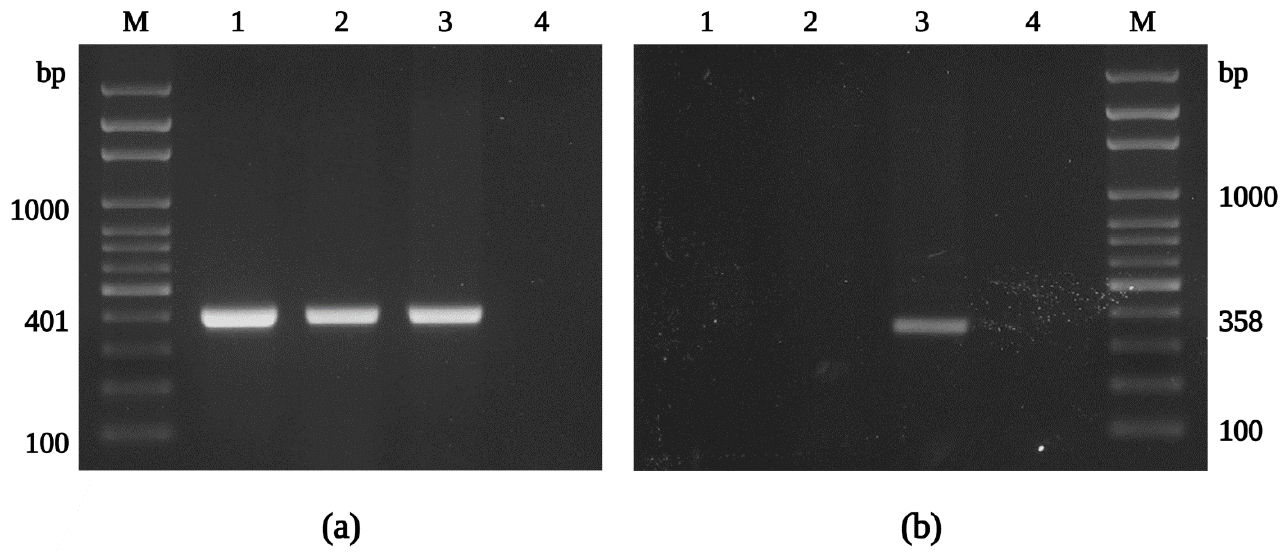
Figure 2. Identification of the isolate Danube by PCR. Agarose gel electrophoresis of PCR products of the genes glt A ( a ) and rff E ( b ), amplified with primers CS-78 and CS-323, MQ32 and MQ33, respectively. M: molecular marker; 1: R. helvetica C9P9; 2: R. helvetica IR16; 3: R. felis Danube; 4: negative control. Note: primer set MQ32, MQ33 does not amplify R. helvetica .